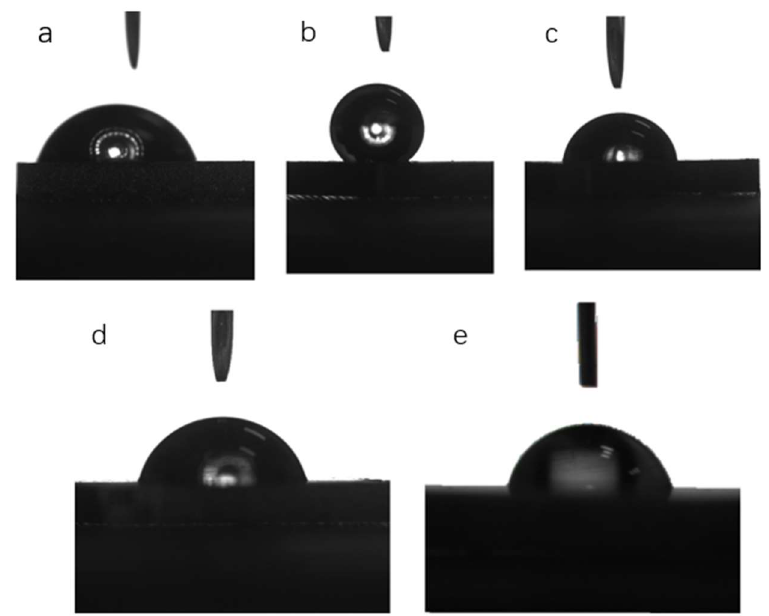
Figure 3. Schematic of the water contact angle of ( a ) groove pattern; ( b ) micro-hole pattern; ( c ) directional grain pattern; ( d ) stripe pattern ( e ) control group. Table 1. The average water contact angle of ( a ) groove pattern; ( b ) micro-hole pattern; ( c ) directional grain pattern; ( d ) stripe pattern ( e ) control group.